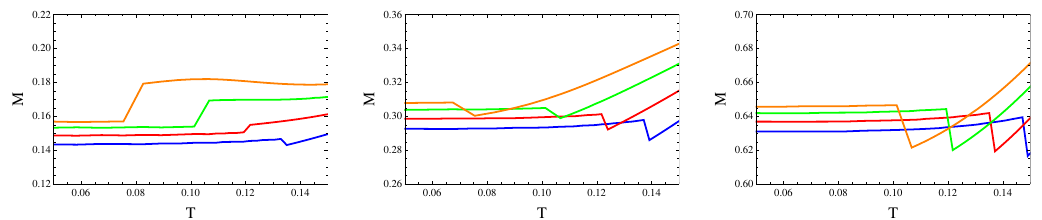
Figure 13 . The magnetisation M as a function of the temperature T for four di(cid:11)erent values of the chemical potential (cid:22) = 0 : 16 (blue), (cid:22) = 0 : 2 (red), (cid:22) = 0 : 23 (green) and (cid:22) = 0 : 25 (orange). The left, center and right panels correspond to b = 0 : 1, b = 0 : 2 and b = 0 : 4, respectively.